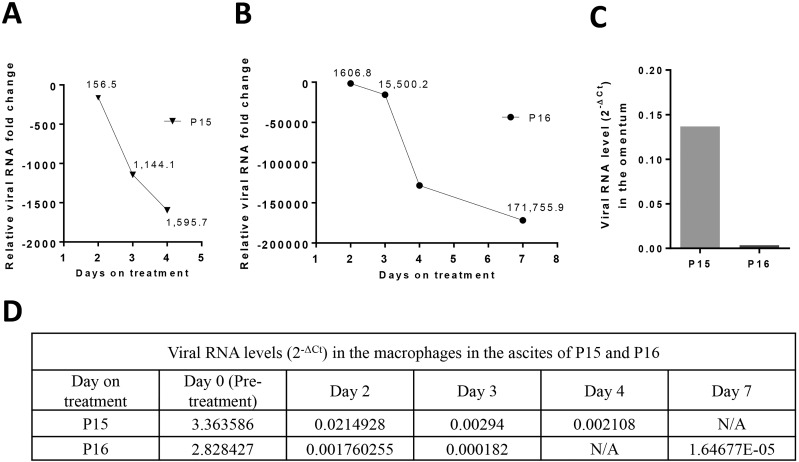
Changes in the viral RNA levels in P15 and P16 before and during antiviral treatment.(A and B) The viral RNA fold changes in the macrophages from the ascites of P15 (A) and P16 (B) over time are shown. The Ct values from viral RNA real-time qRT-PCR were normalized to β-actin and the 2-ΔΔCt method was used to calculate the relative change in viral RNA level, compared to the pre-treatment value. (C) The viral RNA level (2-ΔCt) in the omentum of P15 and P16 which are collected after 4 and 7 days of antiviral treatment, respectively. The bar graph shows the 2-ΔCt values calculated by normalizing the Ct values from viral RNA real-time qRT-PCR to β-actin. (D) The 2-ΔCt values for each viral RNA in the macrophages from the ascites of P15 and P16 at pre-treatment and during treatment are listed in the table. N/A, not available.